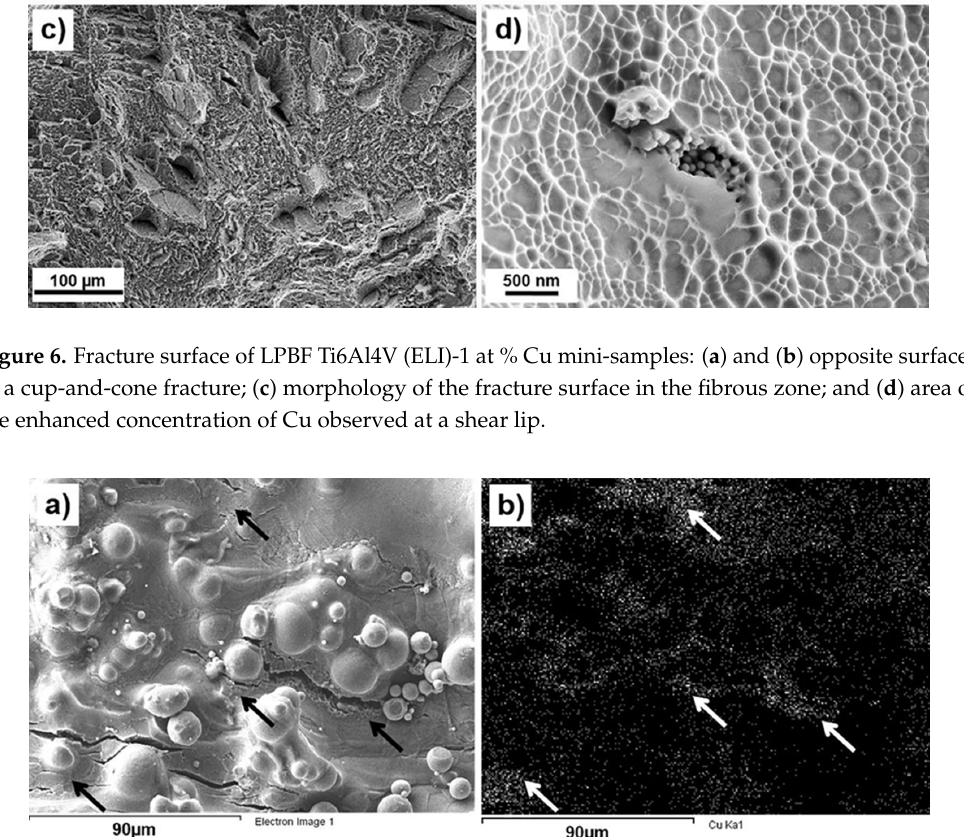
Figure 7. Side surface of LPBF Ti6Al4V (ELI) ‐ 1 at % Cu mini ‐ sample nearby the fracture: ( a ) surface morphology; ( b ) CuK α SEM ‐ EDS map of the same region. Areas of high concentration of Cu marked with arrows.